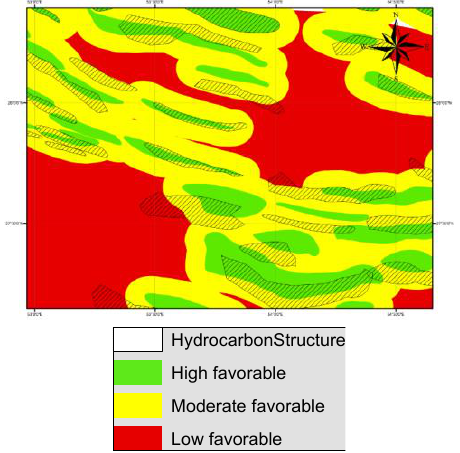
Figure 8.Final CCRS